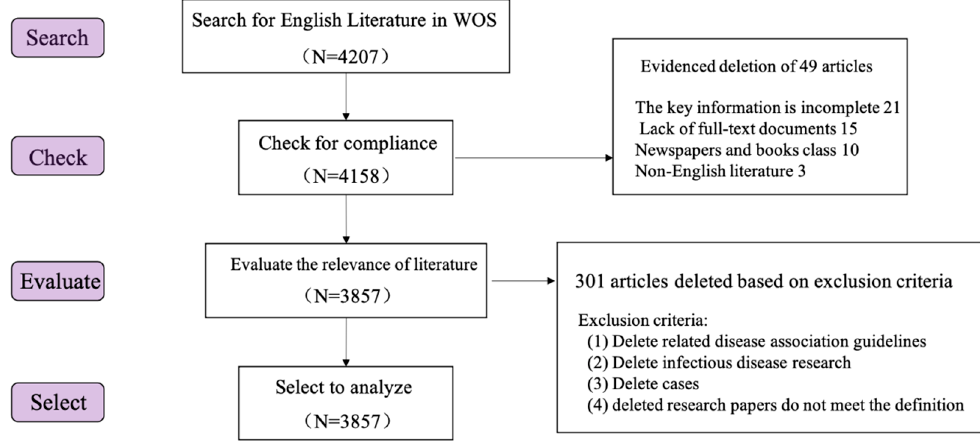
Figure 1. Global literature retrieval process.